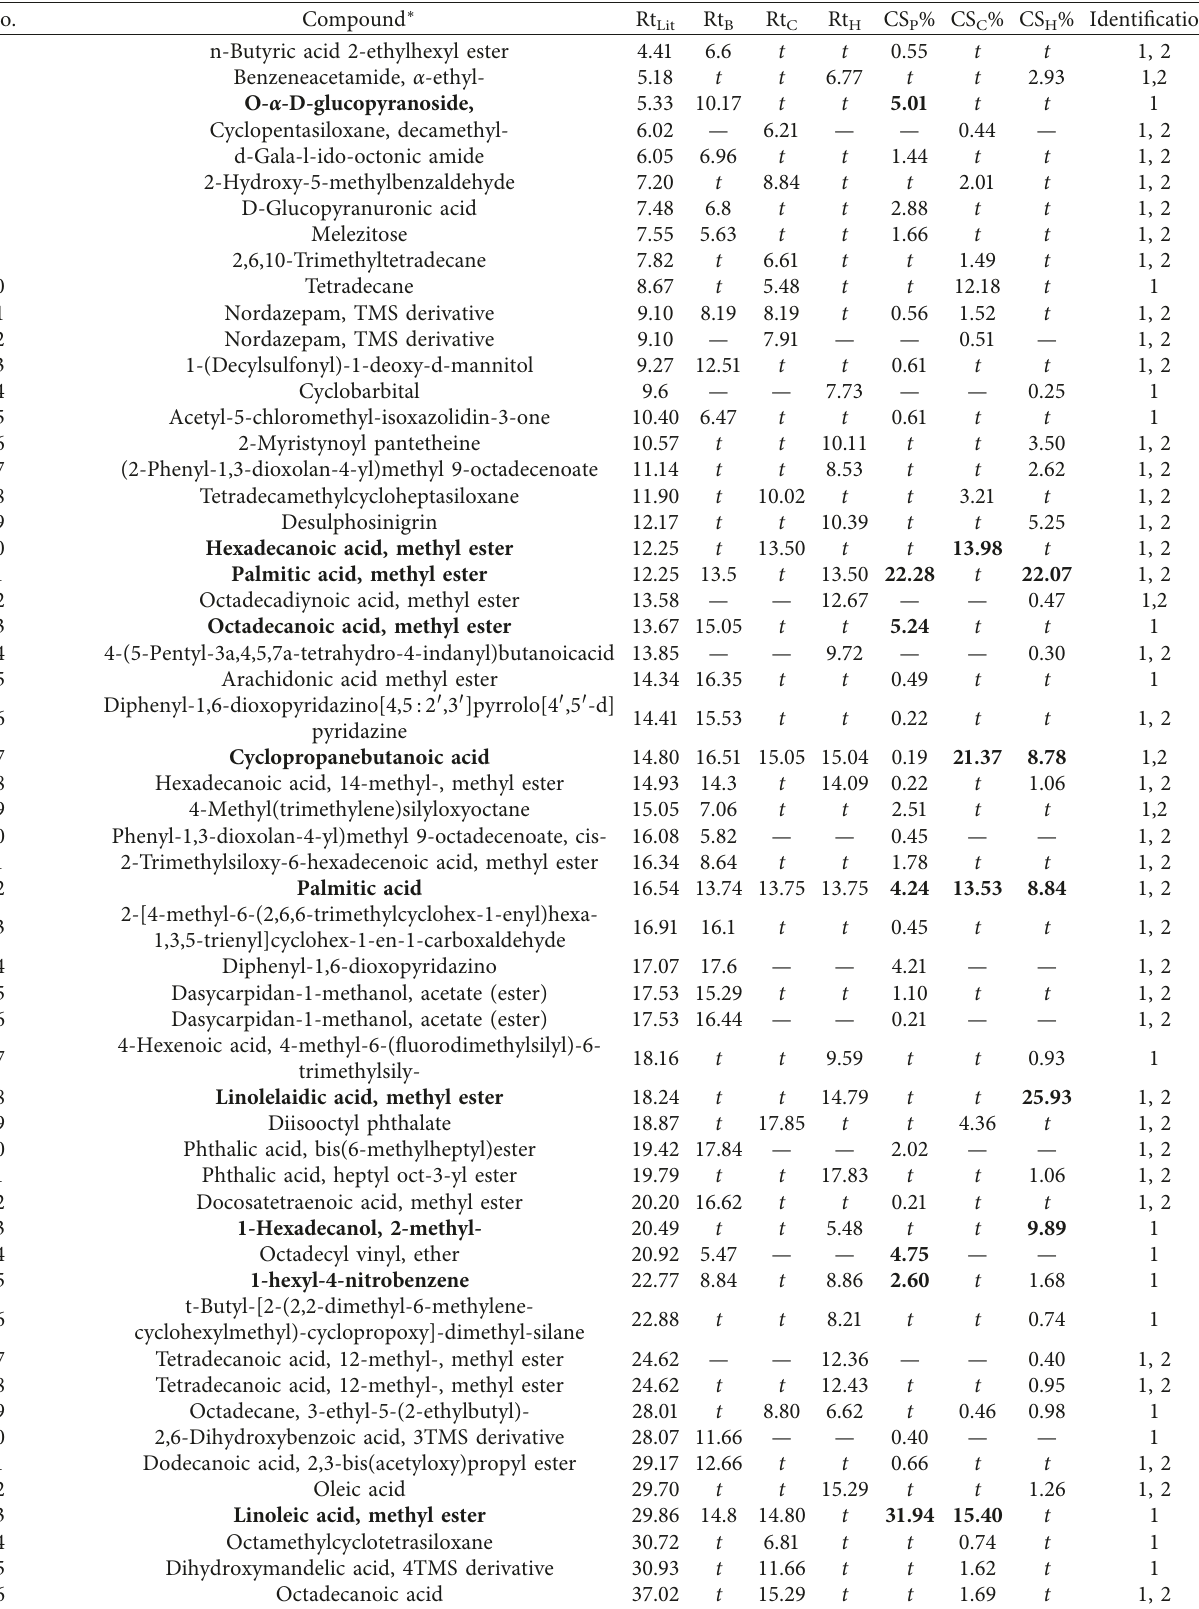
Table 1: Chemical constituents of essential oils derived from vegetable parts (petal, choke, and heart) of C. scolymus L. using GC/MS.